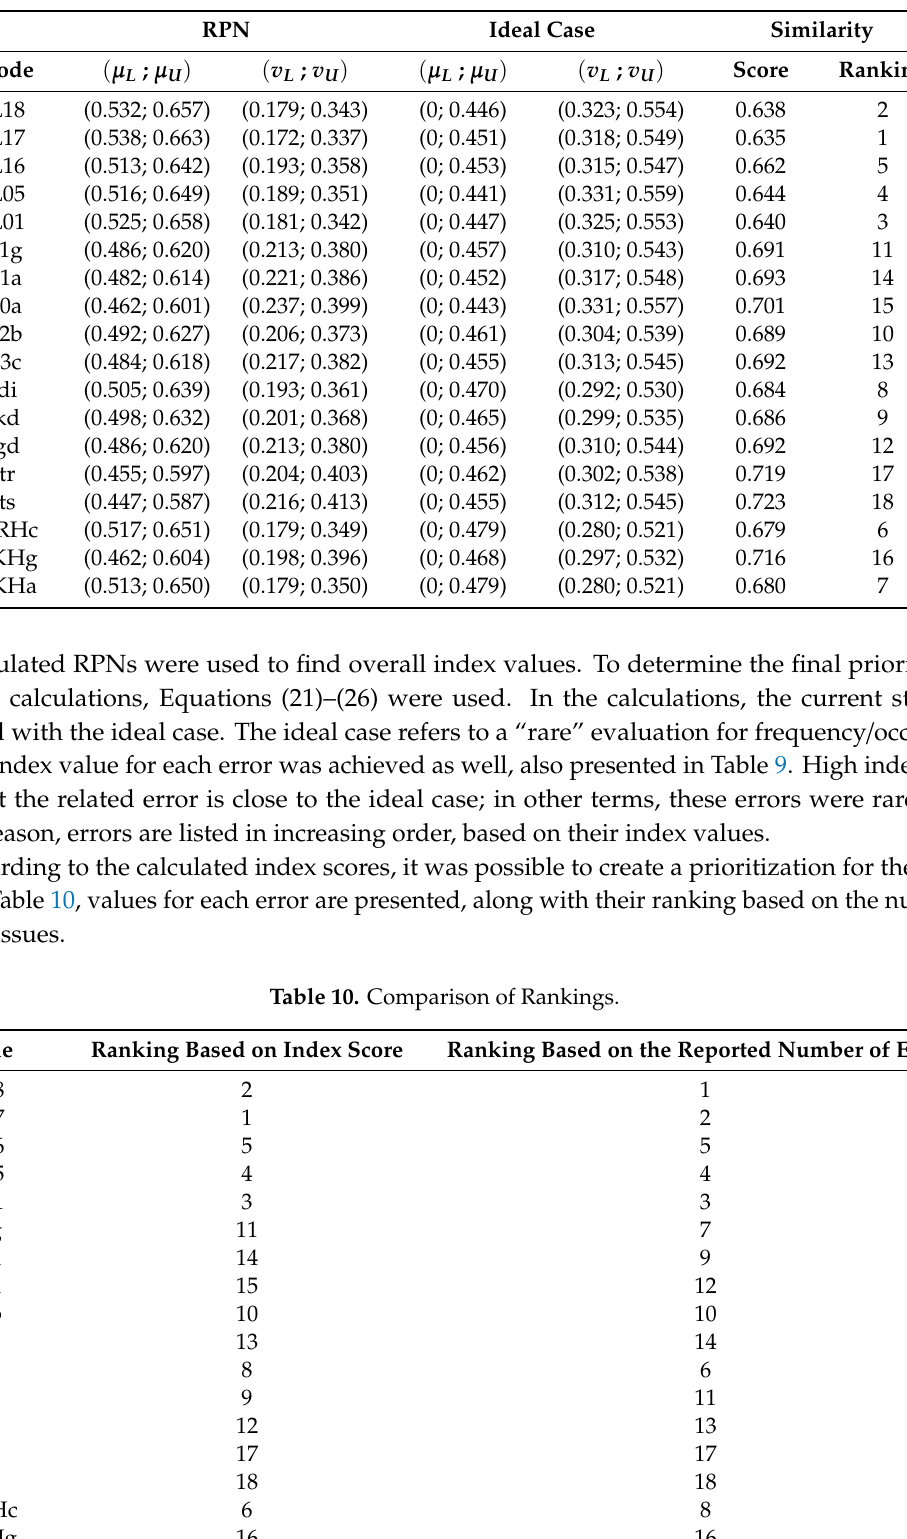
Table 9. Ranking of Errors Based on Index Scores (Preventability × Severity × Occurrence).